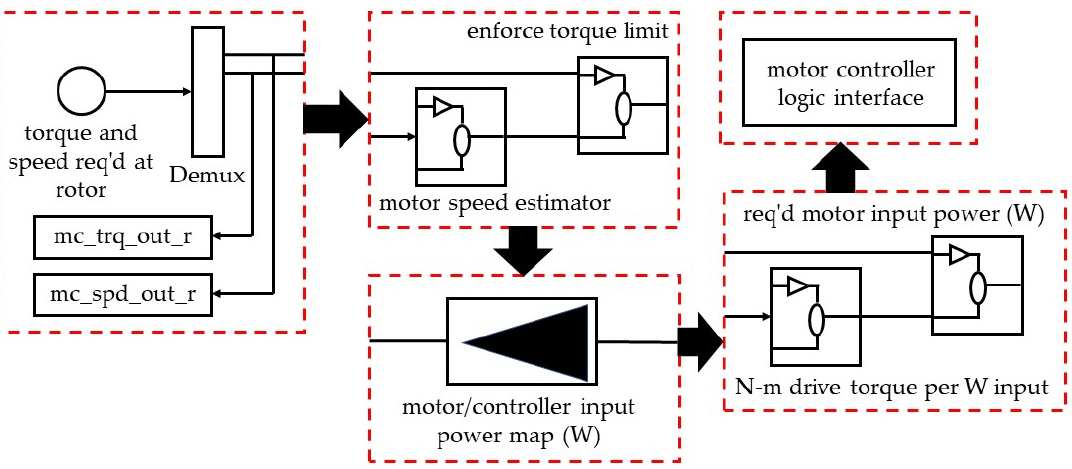
Figure 6. Model flow diagram of the first half.